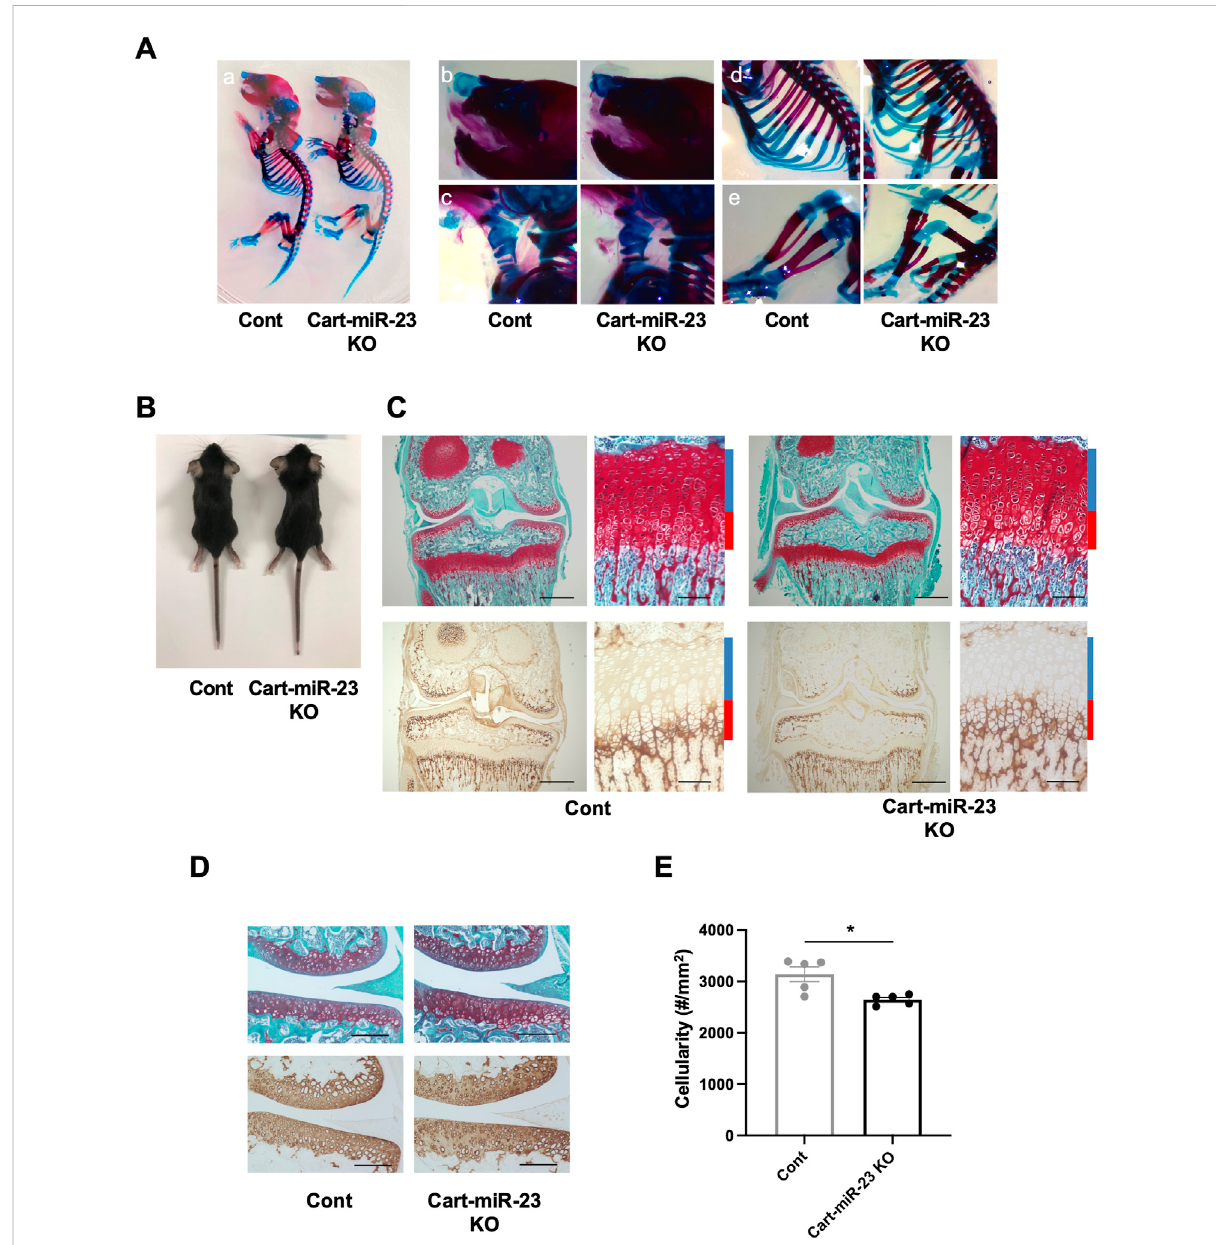
FIGURE 2 Skeletal development in Cart-miR-23clus KO mice. (A) Skeletal preparation with Alcian blue/Alizarin red staining of Control and Cart-miR- 23clus KOmice inpostnatalday0. (A) Wholemount, (B) nasal capsule, (C) trachea, (D) rib cage, (E) hindlimb.Cart-miR-23clus KOmiceexhibitedno overt abnormality in skeletal development. (B) Appearance of Control and Cart-miR-23clus KO mice at 3 weeks of age. Growth retardation was not observed in Cart-miR-23clus KO mice. (C) SafraninO/Fast Green staining and immunohistochemistry (Type XCollagen) in articular cartilage of kneejoints andinthetibialgrowth plateinControlandCart-miR-23clus KOmiceat3 weeksofage. Scalebars:500 μ m and100 µm. (D) SafraninO/ Fast Green staining and immunohistochemistry (Type II Collagen) in articular cartilage of knee joints in Control and Cart-miR-23clus KO mice at 3 weeks of age. Scale bars: 200 µm. (E) Cellularity in articular cartilage of Control and Cart-miR-23clus KO mice ( n = 5 per group). The data represented as mean ± SEM. Comparison of mean values was performed using Welch ’ s t -test; * p <